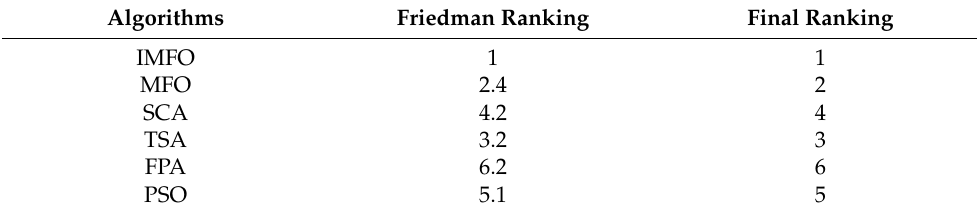
Table 6. Friedman ranking test for all compared metaheuristic algorithm.